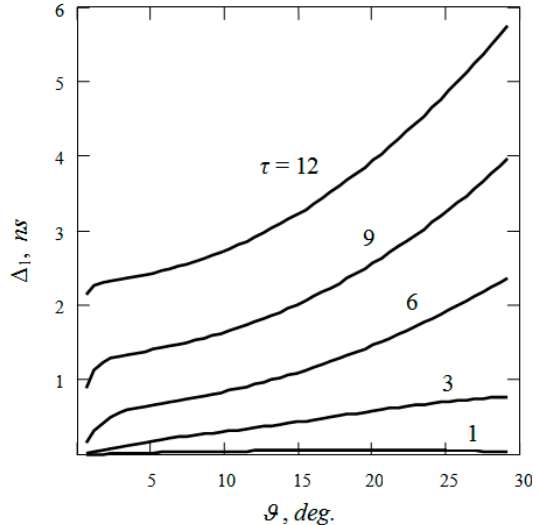
( / ) t r c Δ = − (in nanoseconds) because 1 w